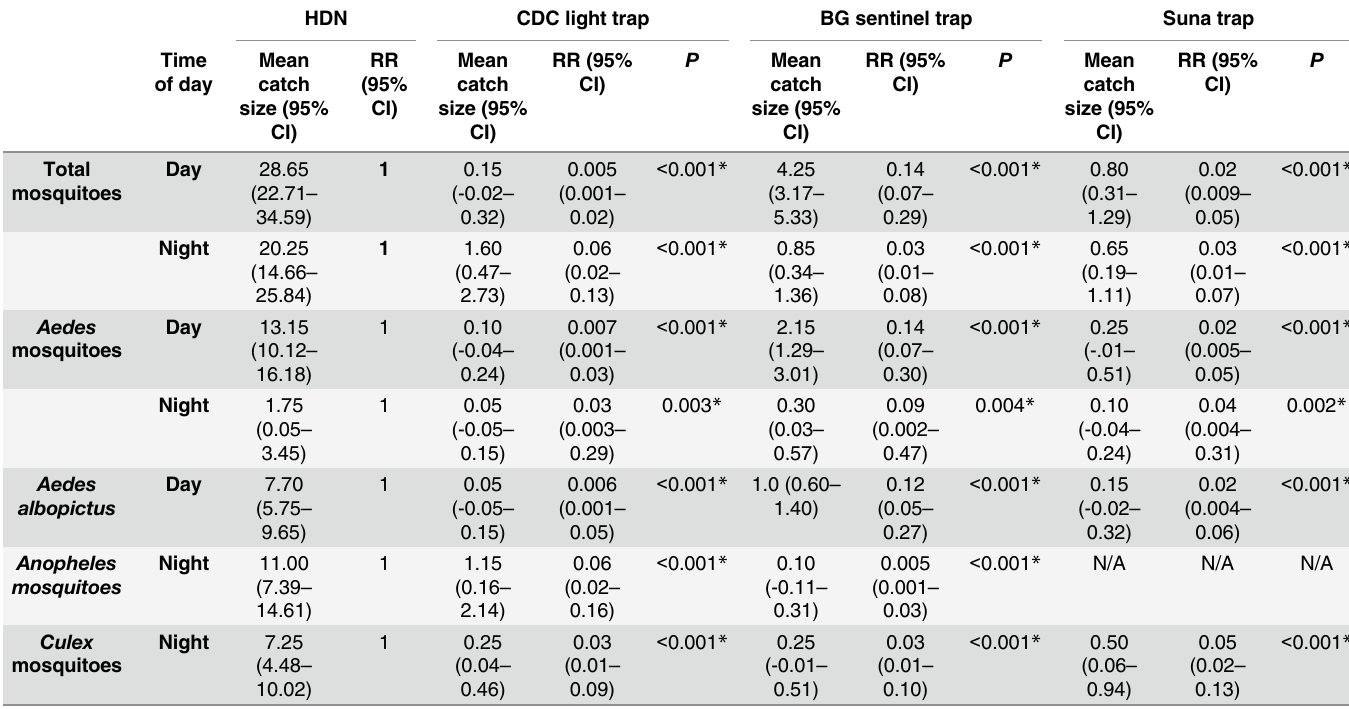
Table 2. Means and rate ratio of female mosquitoes collected by the human-baited double net trap and outdoor traps comparison (experiment 1).